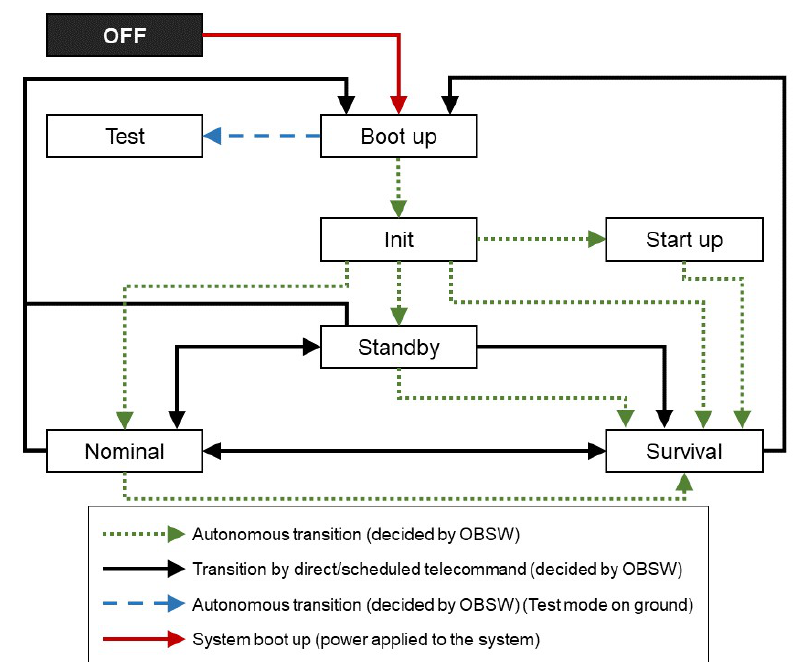
Figure 5. AlfaCrux operational modes schematic.